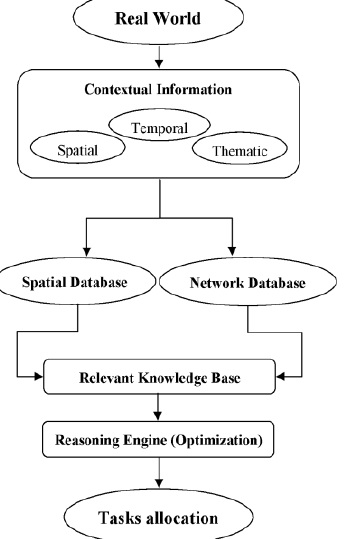
Figure 3: Context-aware relief & rescue teams framework In the following